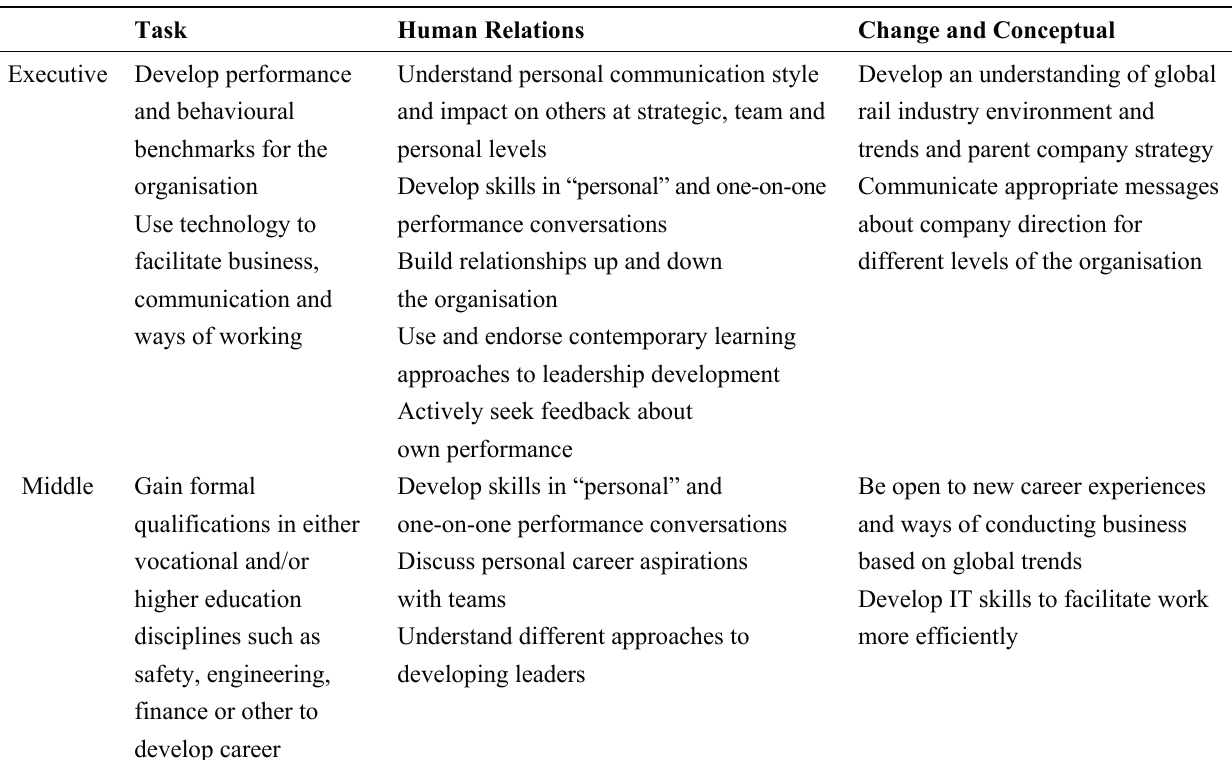
Table 2. Areas for Development for